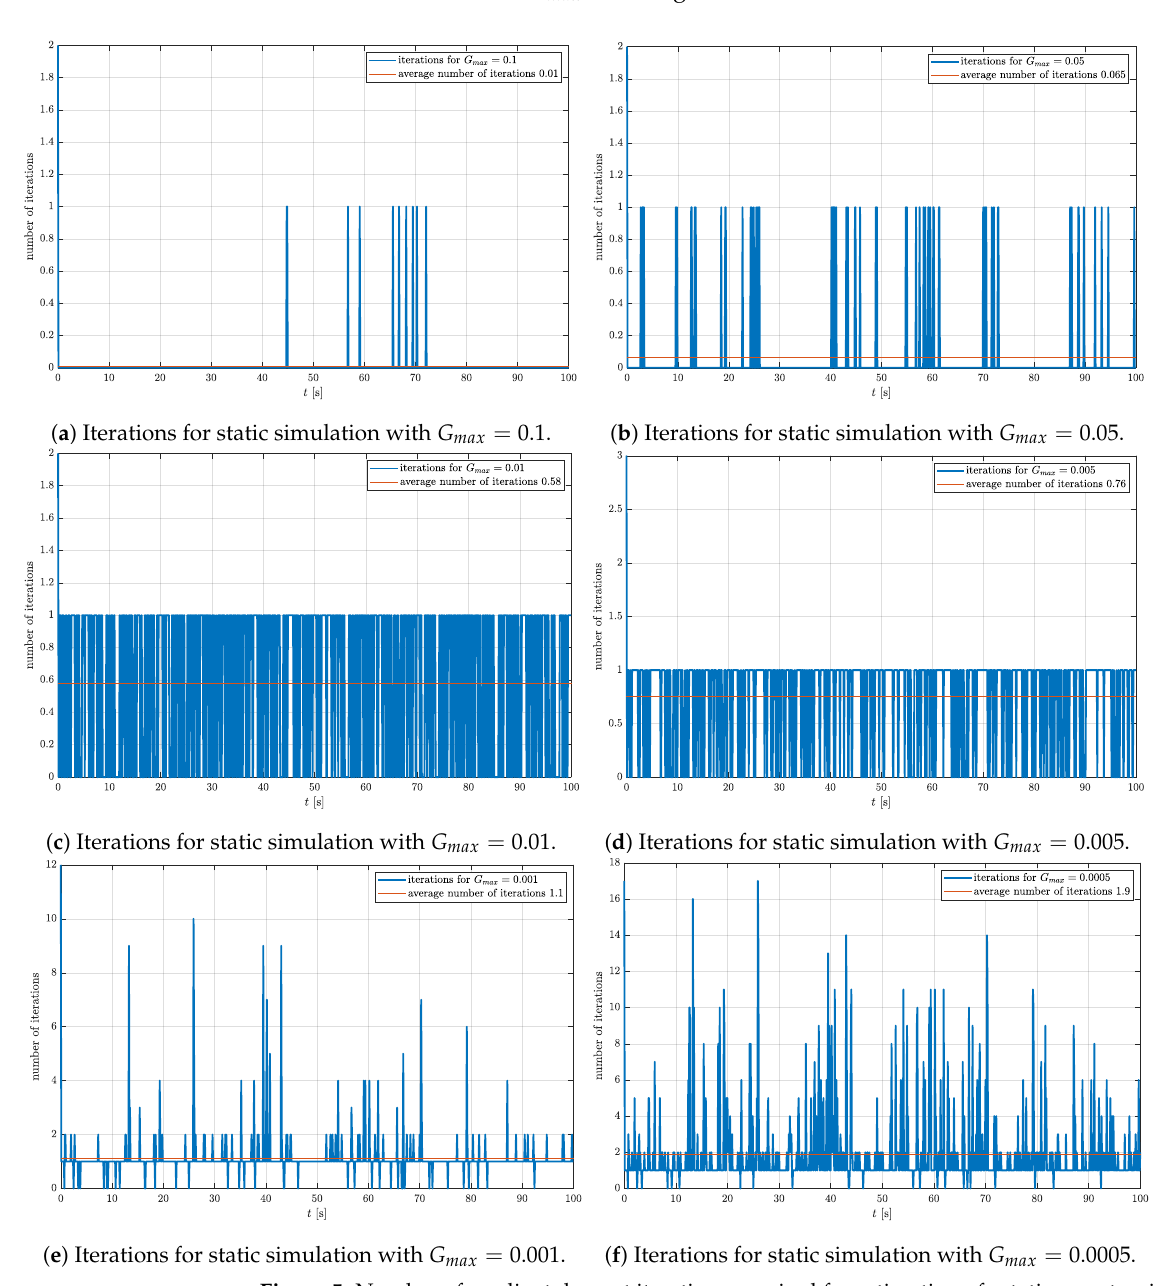
Figure 5. Number of gradient descent iterations required for estimation of rotation quaternion based on a previous estimate in static condition for six values of G max in range from 1 × 10 − 1 to 5 × 10 − 4 and for µ =